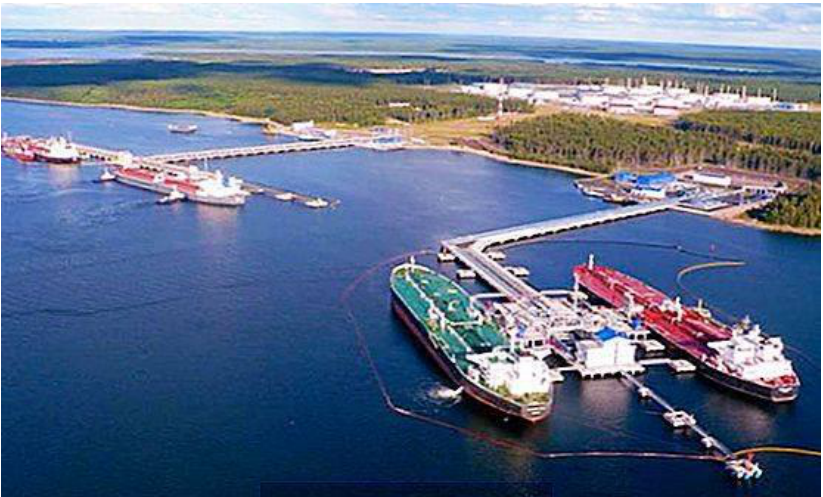
Figure 9. Primorsk Commercial Sea Port. Source: [78].